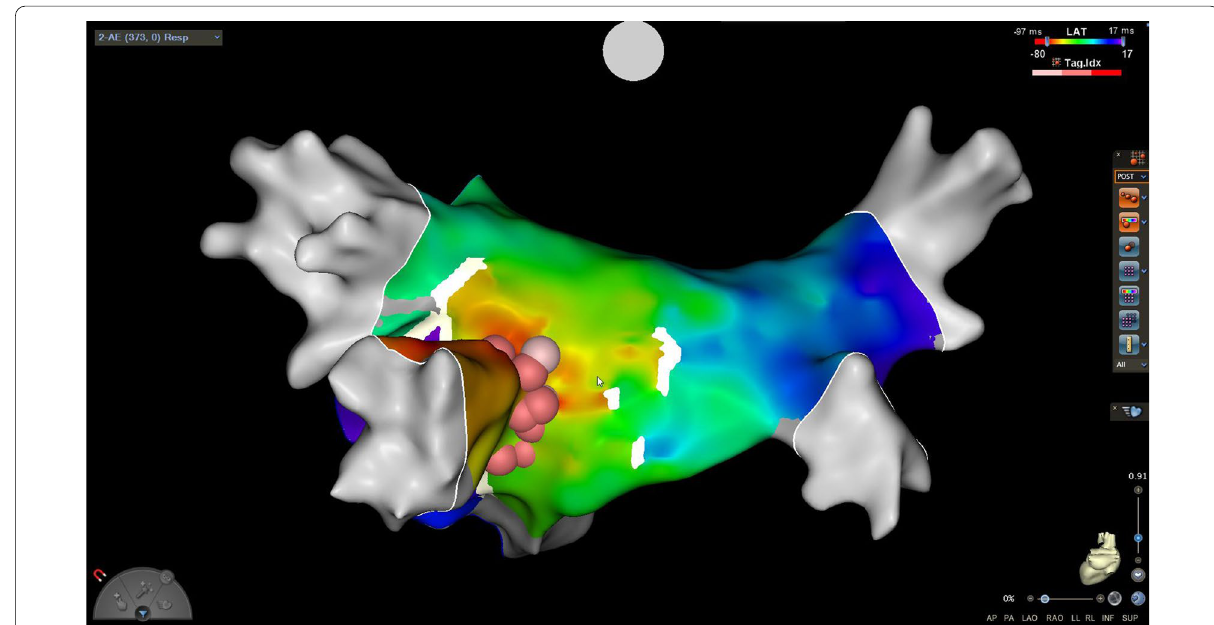
Fig. 5 The electrical isolation of the lower left pulmonary vein with radiofrequency catheter ablation was performed with total suppression of the ectopic foci (CARTO ©3D Mapping